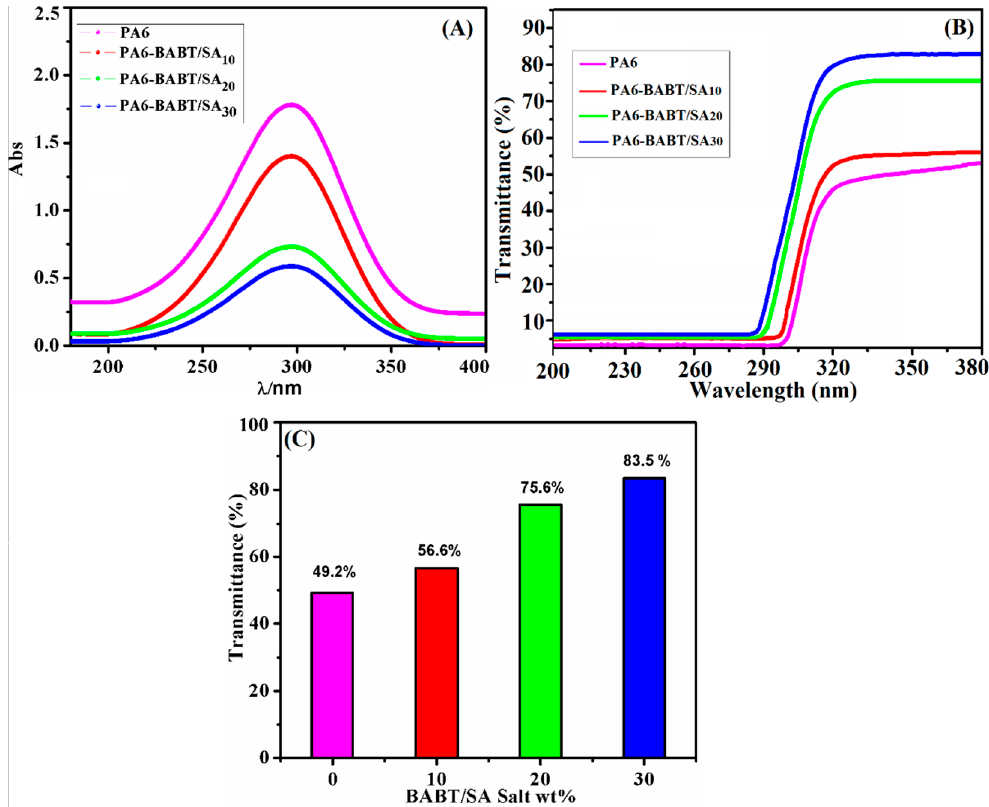
Figure 16. ( A ) The ultraviolet (UV) spectra of polyamide samples with different BABT/SA contents. ( B ) UV-visible transmittance spectra of neat PA6 and PA6-BABT/SA copolaymides. ( C ) Transmittance values of the polyamides films with different content of BABT/SA.